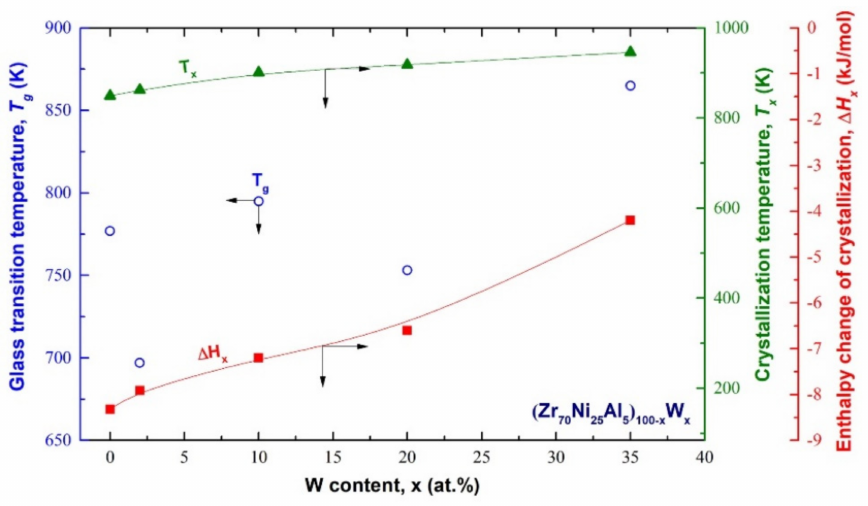
Figure 9. Effect of W (x) concentration on the glass transition (T g ), crystallization (T x ) tem- peratures, supercooled liquid region ( ∆ T x ), and enthalpy change of crystallization ( ∆ H x ) for (Zr 70 Ni 25 Al 5 ) 100-x W x metallic glassy systems.